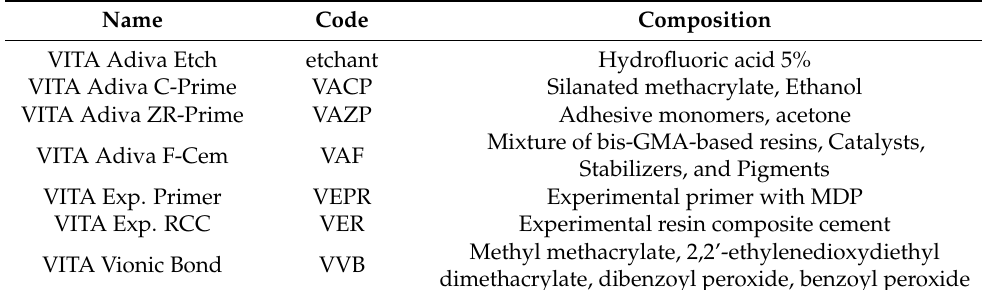
Table 1. Composite resin cement and primer used in the study (material compositions according to the manufacturer’s product specification).